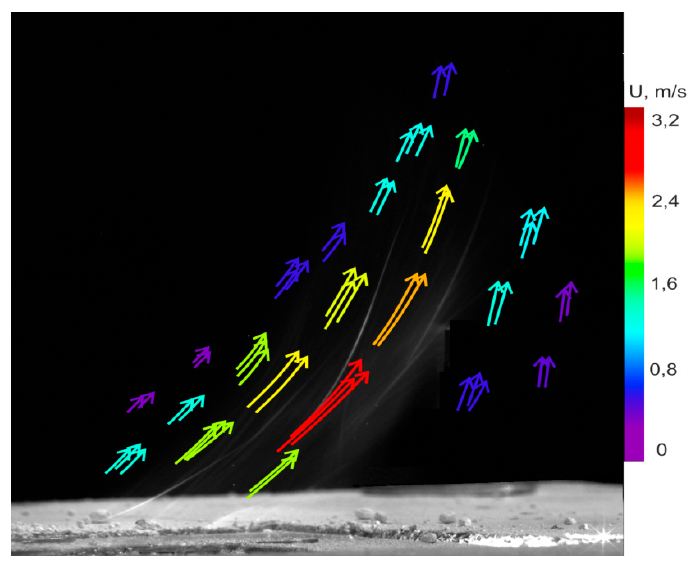
Figure 14. Velocity field in the combustion region obtained using the PTV method ( U 0 = 0.5 m/s, t = 20 s). The maximum gas velocity in the combustion zone is approximately equal to U c = 3.5 m/s.